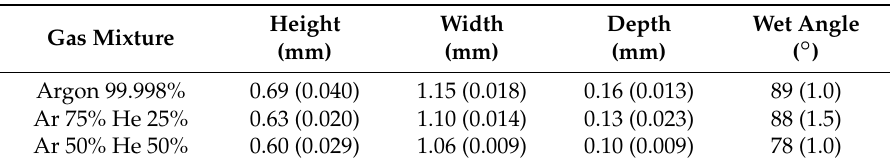
Table 6. Summary of results for experimental tests at 400 W. (absolute deviation around the mean (MAD) in brackets).